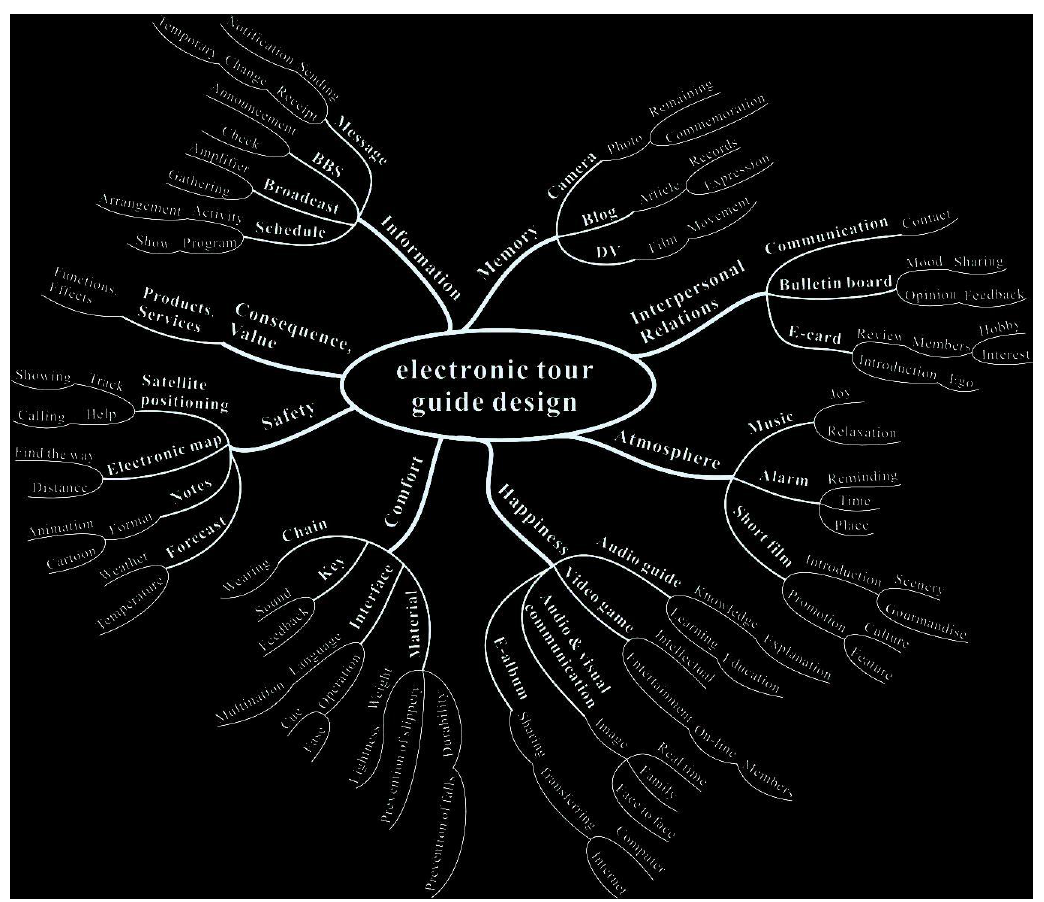
Figure 7. Mind Map for electronic tour guide design